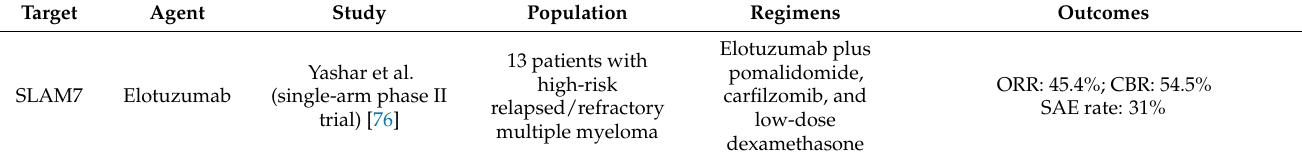
Table 2. Relevant clinical data of immunotherapy agents with potential effect on NK cells. Legend -> AE: adverse event; CI: confidence interval; CBR: clinical benefit rate; HR: hazard ratio; ITT: intent-to- treat; MTD: maximum-tolerated dose; NR: not reached; NSCLC: non-small cell lung cancer; ORR: objective response rate; RCC: renal cell carcinoma; SAE: severe adverse events. * p values were not reported in the interim